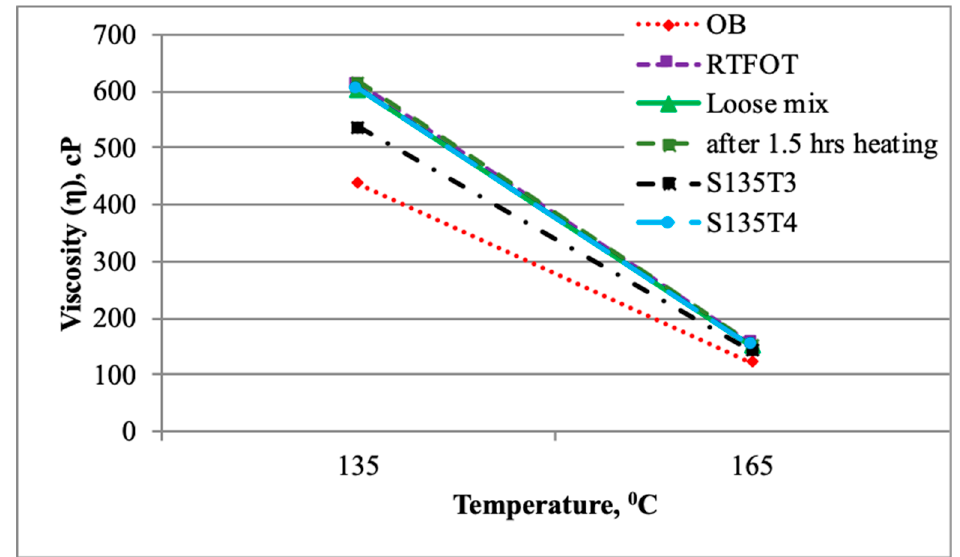
Figure 10. Comparison of viscosity results of unmodified binders recovered from mixture 1.